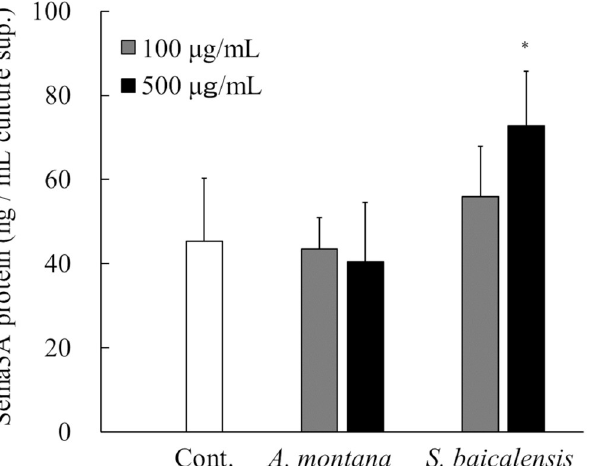
Fig 4. Effects of S . baicalensis and A . montana extracts on Sema3A production in RHE models. A 100 μ L sample of the extract of S . baicalensis , A . montana (100 or 500 μ g/mL) or PBS (vehicle) was applied from the stratum corneum side of cultured RHE samples, and the RHE samples were cultured for a further 24 hours. The culture supernatants were collected, and then the concentrations of Sema3A protein were measured using ELISA. All results are expressed as means ± S.D. of three independent experiments. � p < 0.05, (one-way ANOVA followed by Dunnett’s